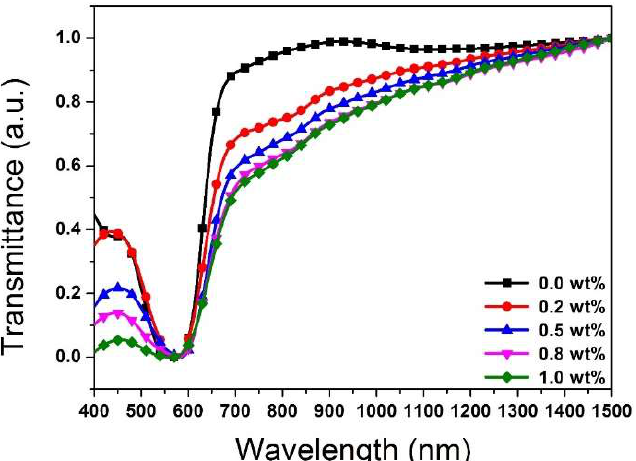
Figure 3. UV transmittance spectra of LC mixtures with different concentrations of CNT/PVP (samples 0 , 5 , 6 , 7 , and 8 ).